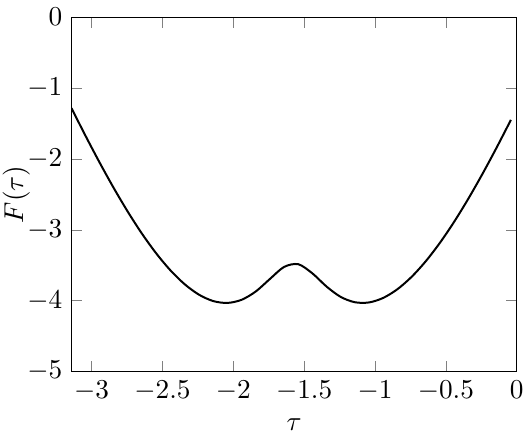
Figure 13 . The function F of eq. (C.3) for y =